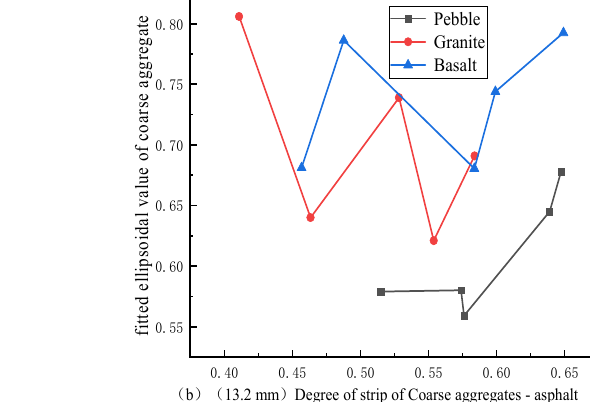
Figure 22. Relationship between degree of strip and the change rate of angularity.